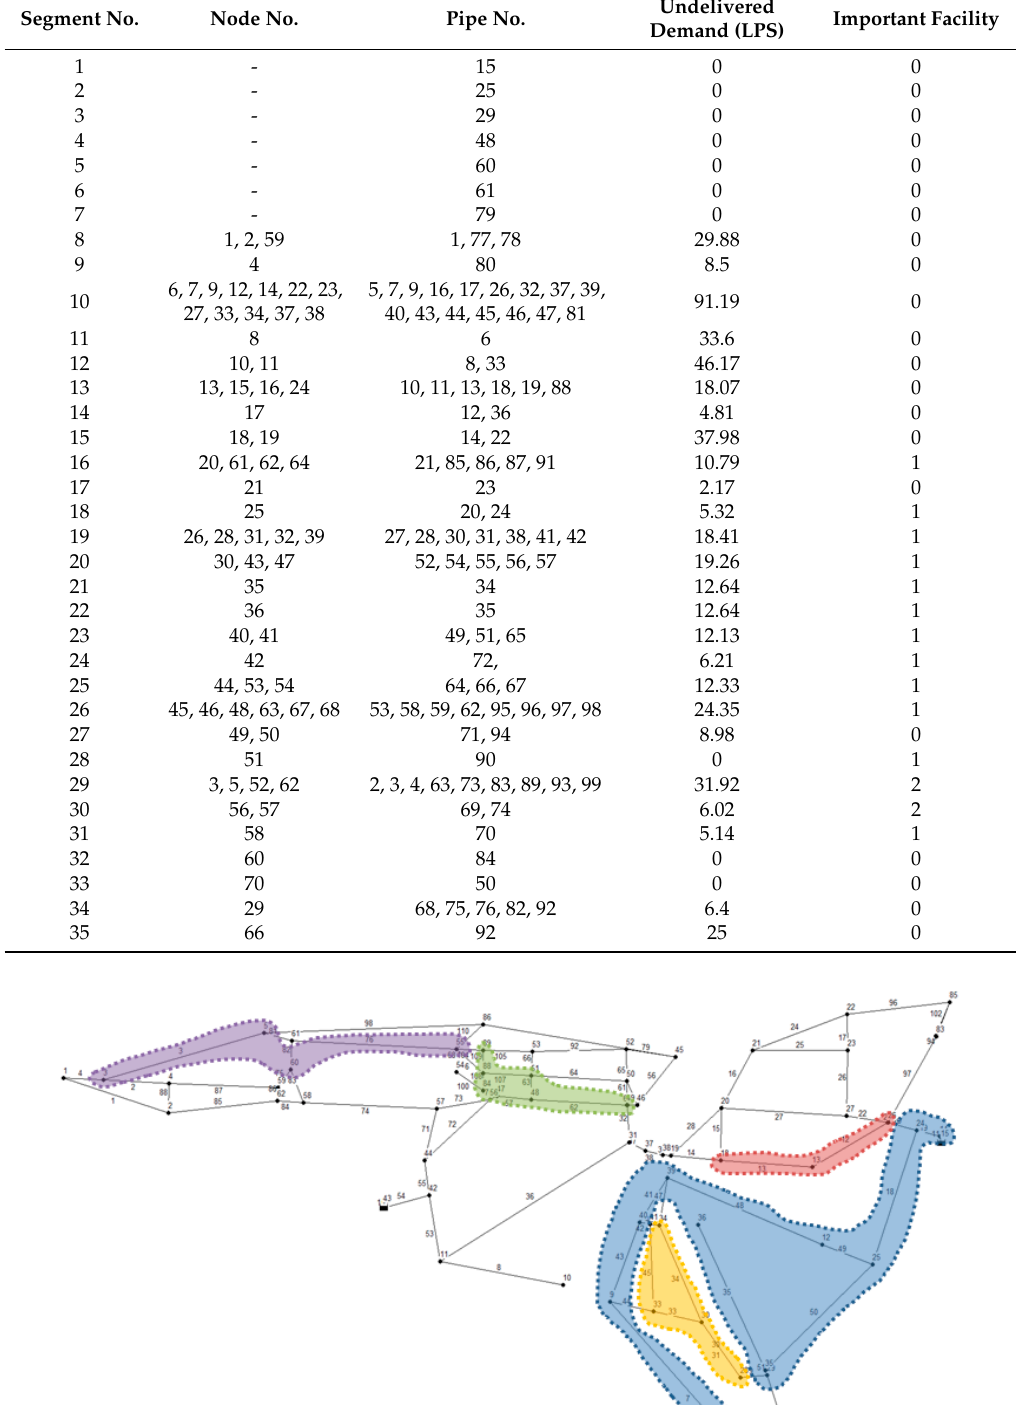
Table 6. Segment identification result of Pescara network.